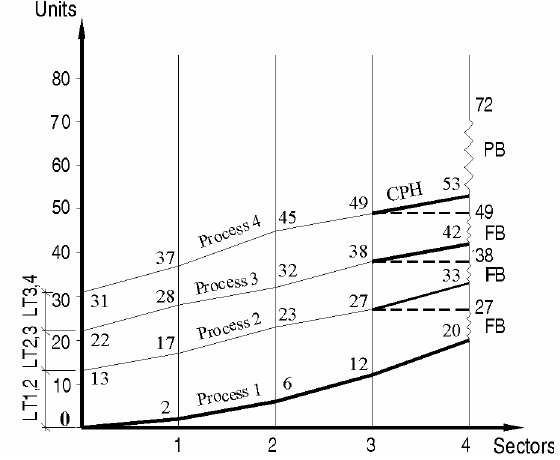
Fig 9. Cyclogram with critical chain and time buffers (Units, Process 4, …, Sectors)